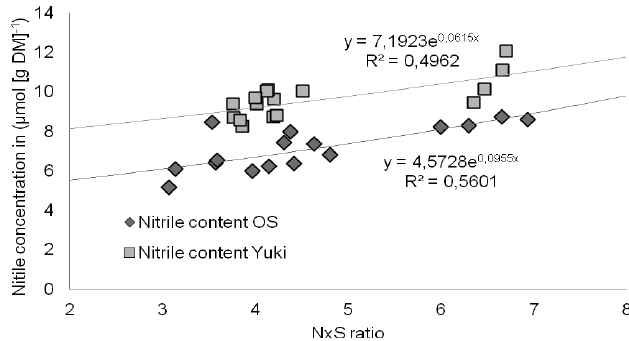
Fig. 7: Influence of different the cvs. Yuki (Y) and Orient Surprise (OS) and the N×S ratio on the nitrile concentration in Chinese